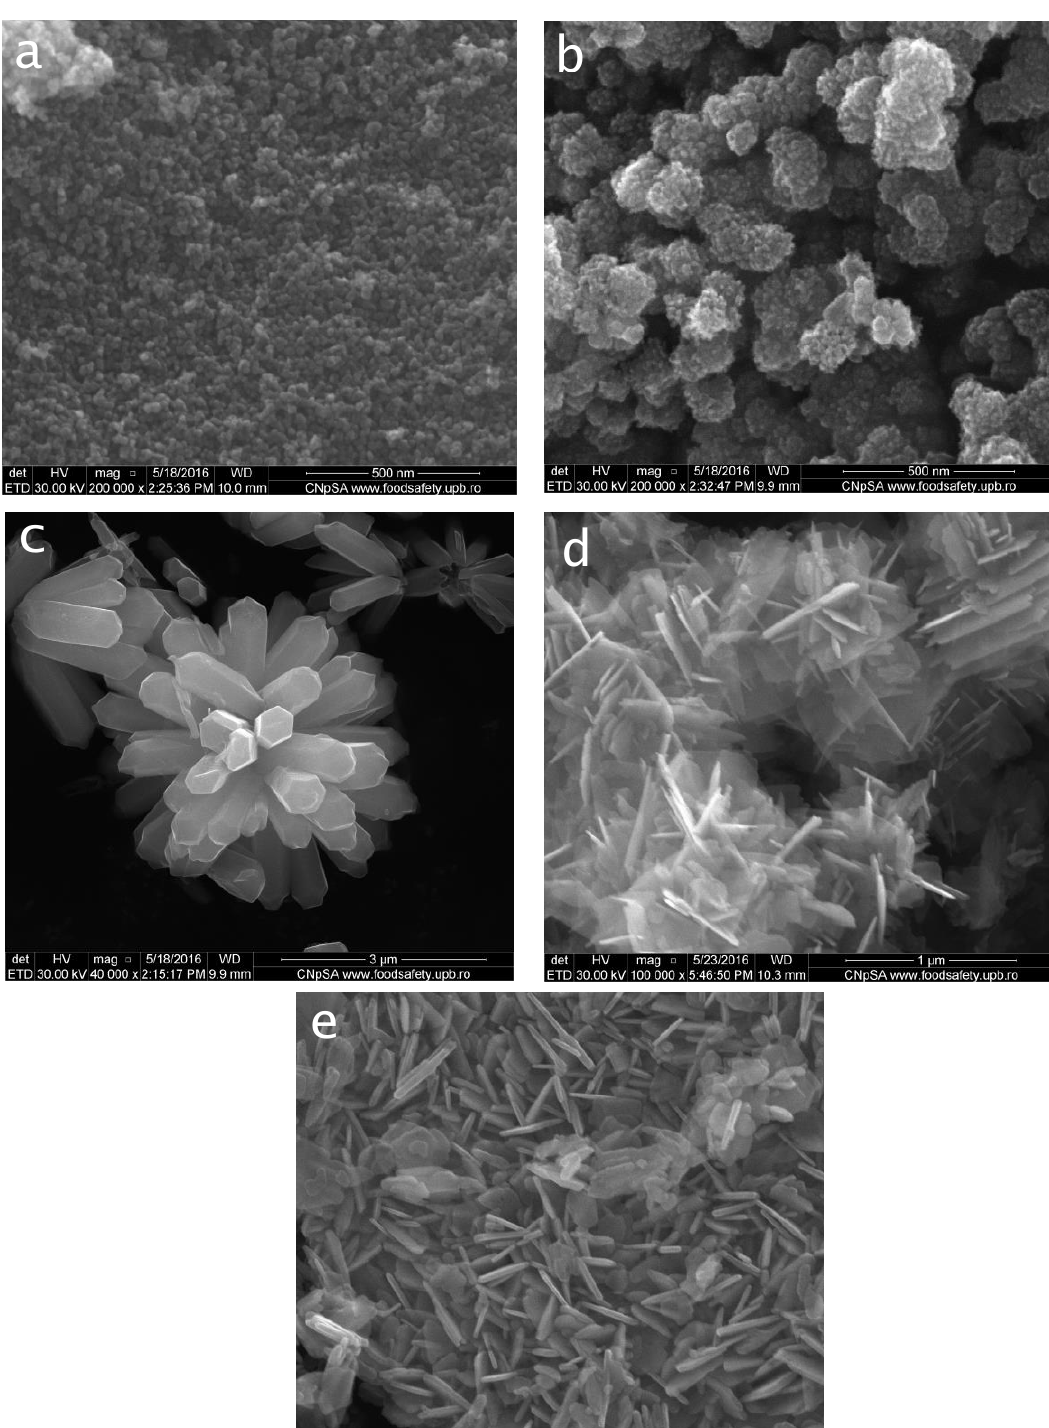
Figure 2. Scanning Electronic Microscopy (SEM) images of zinc oxide powder obtained by polyol (( a )—P1, ( b )—P2) and hydrothermal (( c )—H1, ( d )—H2, ( e )—H3) methods.